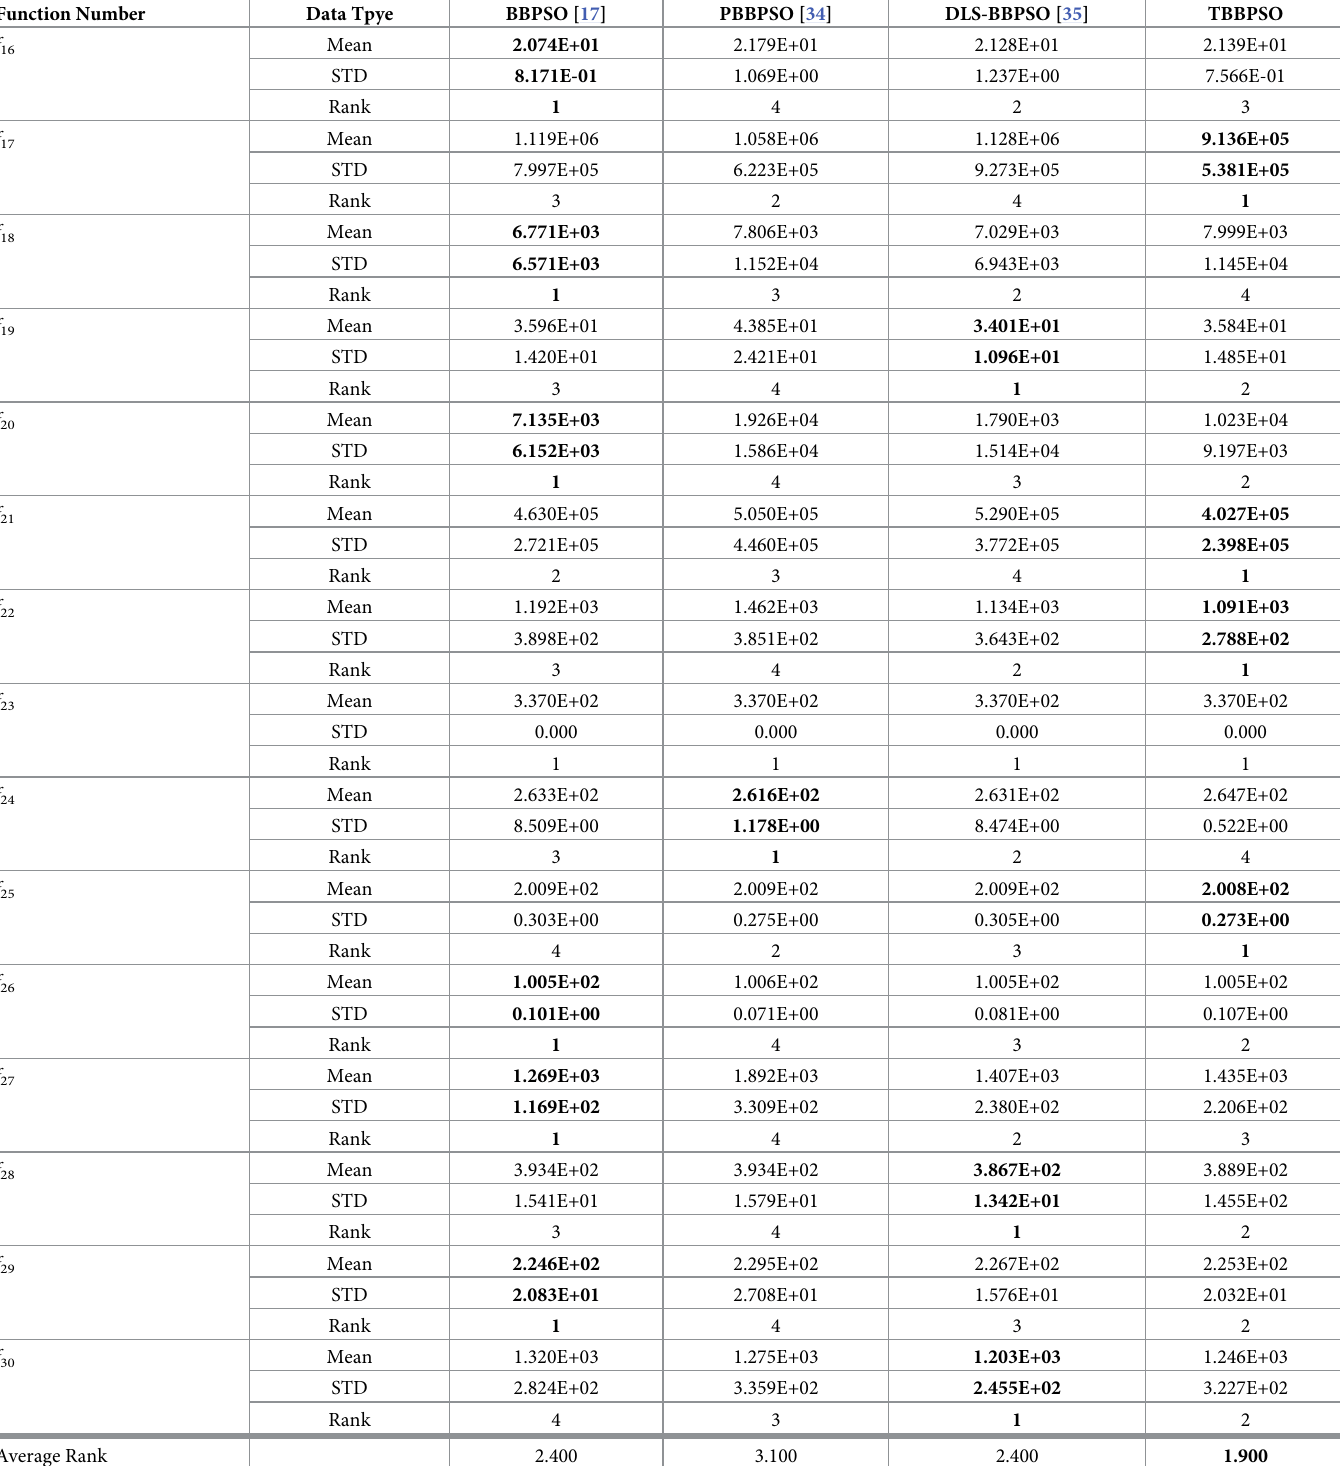
Table 4. Experimental Results, ME of BBPSO, PBBPSO, DLS-BBPSO and TBBPSO for f 16 – f 30 . Mean is the mean value from 31 independent runs, STD is the standard deviation of the 31 runs, Rank is the rank of 4 algorithms. Average rank point is at the bottom of the table. Function